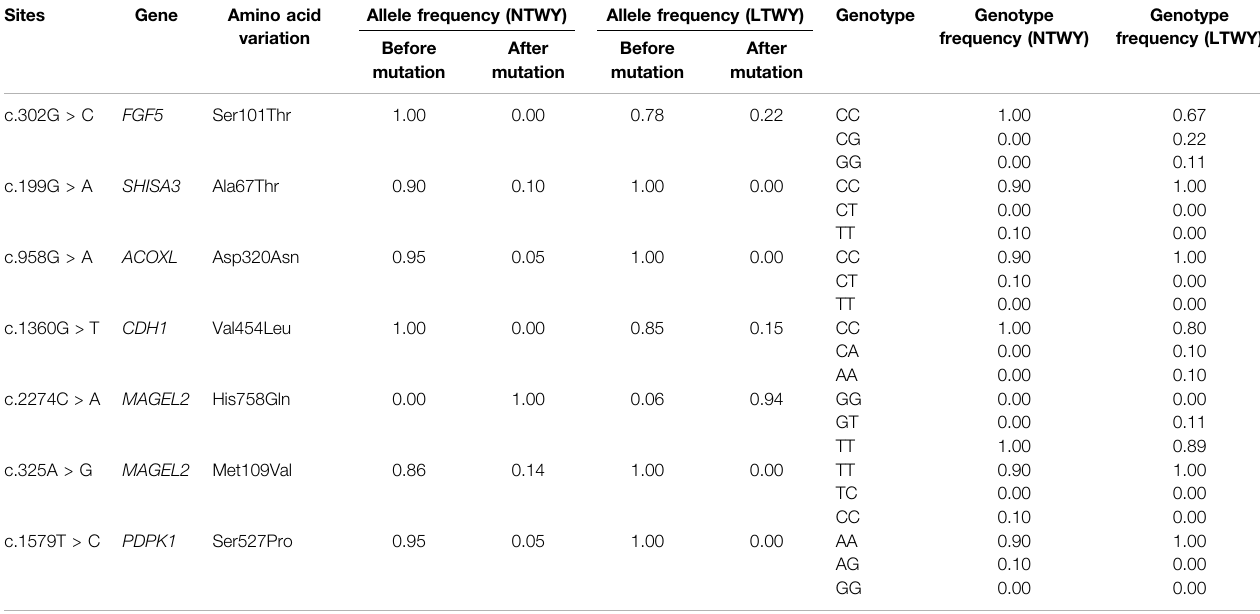
TABLE 3 | Allele frequencies for missense mutations in the candidate genes identi fi ed in NTWY and LTWY.